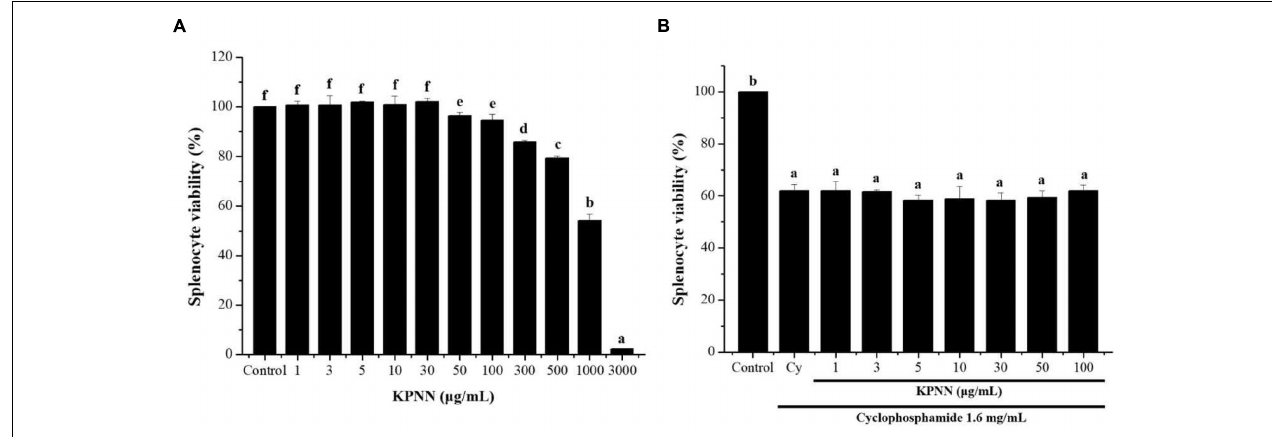
FIGURE 3 | Effects of KPNN on Cy-induced splenocytes. (A) Isolated splenocytes were seeded in 96-well plates (1 × 10 6 cells/90 µ l/well) and treated with KPNN (0, 1, 3, 5, 10, 30, 50, 100, 300, 500, 1,000, and 3,000 µ g/ml) for 24 h. Then, cell proliferation was determined using a WST-1 assay. (B) Splenocytes were seeded into 96-well plates, followed by treatment with KPNN (0, 1, 3, 5, 10, 30, 50, and 100 µ g/ml) and Cy (1.6 mg/ml) for 24 h. Cell viability was measured using a WST-1 kit. Data are expressed as mean ± SEM of three independent experiments. p < 0.05 vs. control group ( n = 3). Bars labeled with different superscript numerals indicate p < 0.05.